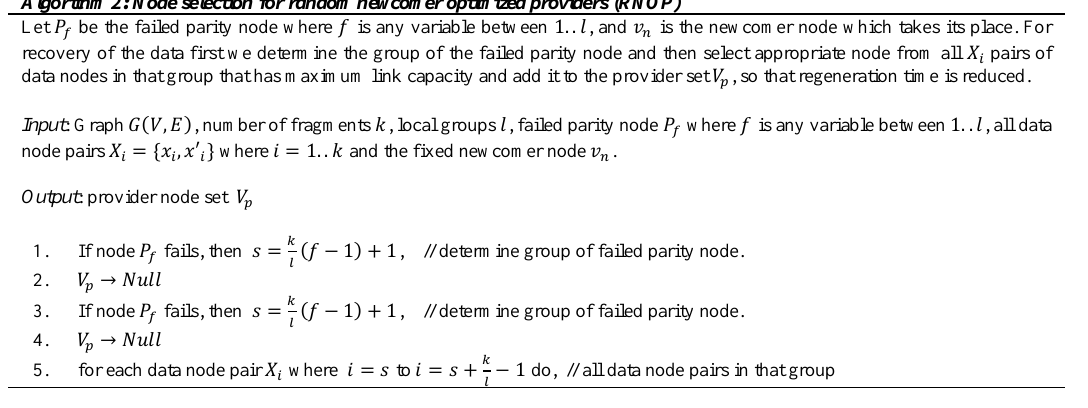
Algorithm 2: Node selection for random newcomer optimized providers (RNOP) Let